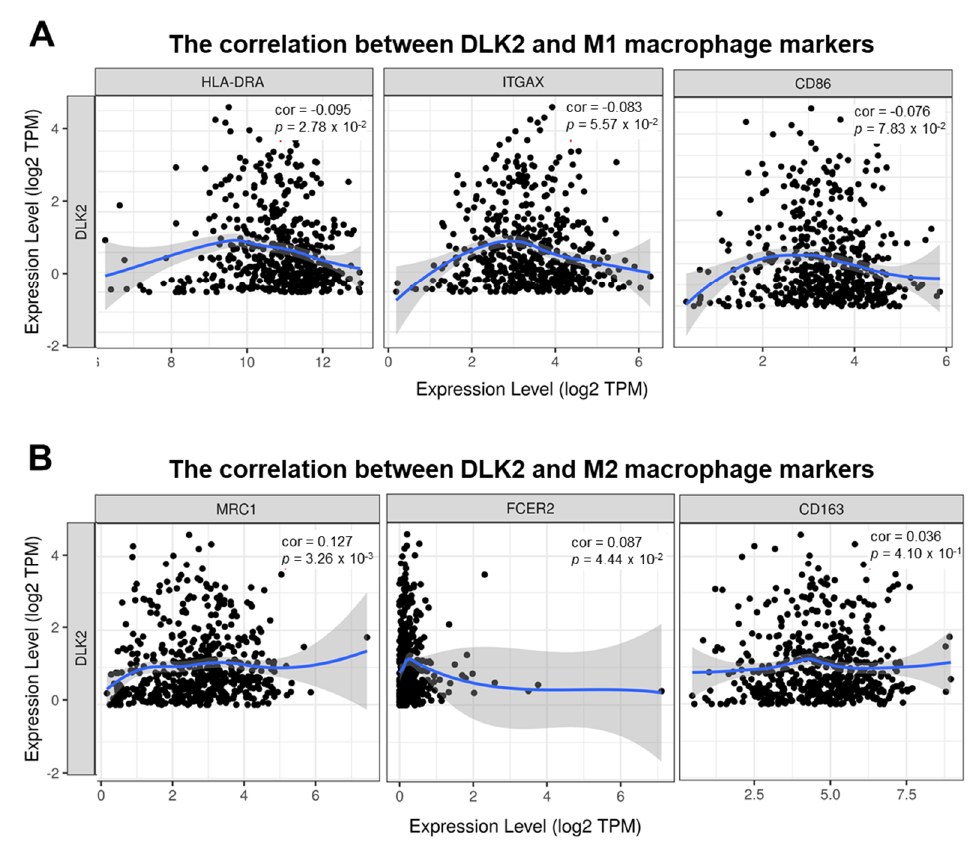
Figure 11. The DLK2 expression is associated with the M1 to M2 polarization of macrophages in ccRCC based on the TIMER analysis. The correlation between DLK2 level and the expressions of ( A ) M1 or ( B ) M2 macrophage markers in ccRCC tissues.